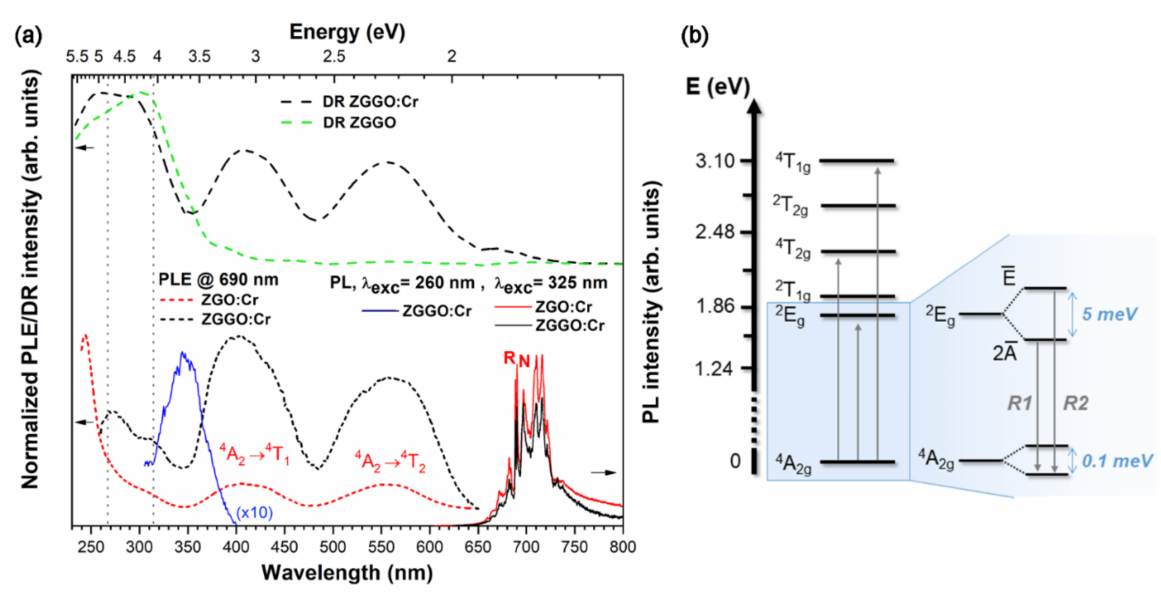
Figure 4. ( a ) ( top ) DR spectra of non-intentionally doped (green dashed line) and chromium-doped (black dashed line) ZGGO samples; ( bottom ) RT PLE (@ 690 nm) and PL ( λ exc = 325 nm) spectra of ZGGO:Cr (black lines) and ZGO:Cr (red lines) samples, respectively; and a PL spectrum of ZGGO:Cr (blue solid line) at band-to-band excitation. ( b ) Schematic representation of the energy levels of Cr 3+ in octahedral sites and corresponding splittings (not to scale) of the fundamental and first excited states under the interplay of a trigonal crystalline field and spin–orbit